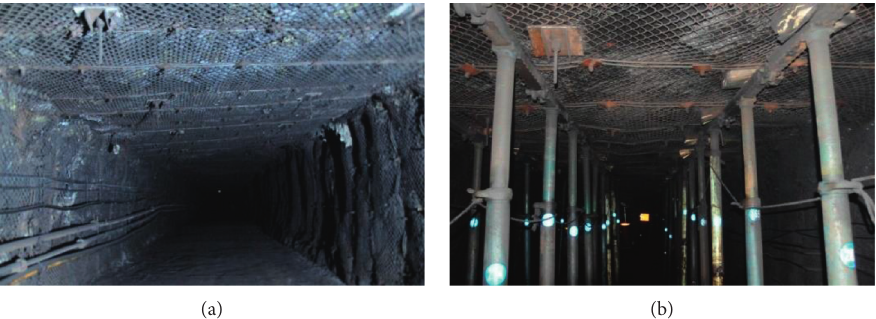
Figure 15: Deformation of roadway surrounding rock. (a) Roadway excavation; (b) working face